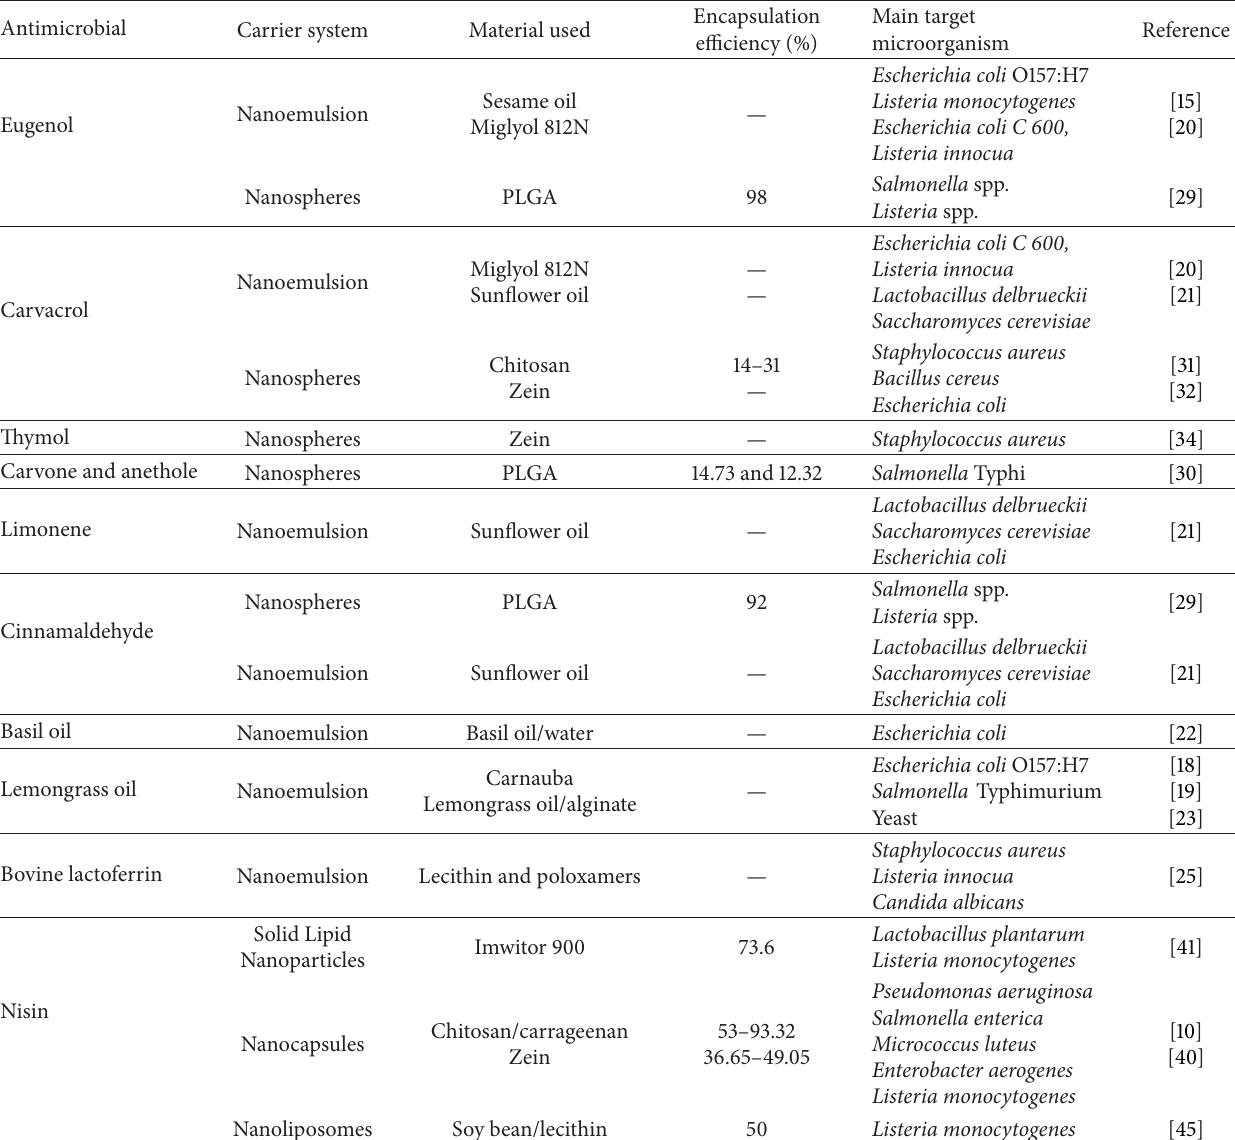
Table 2: Examples of food antimicrobials encapsulated in nanoemulsions, nanospheres, nanocapsules, and nanoliposomes.